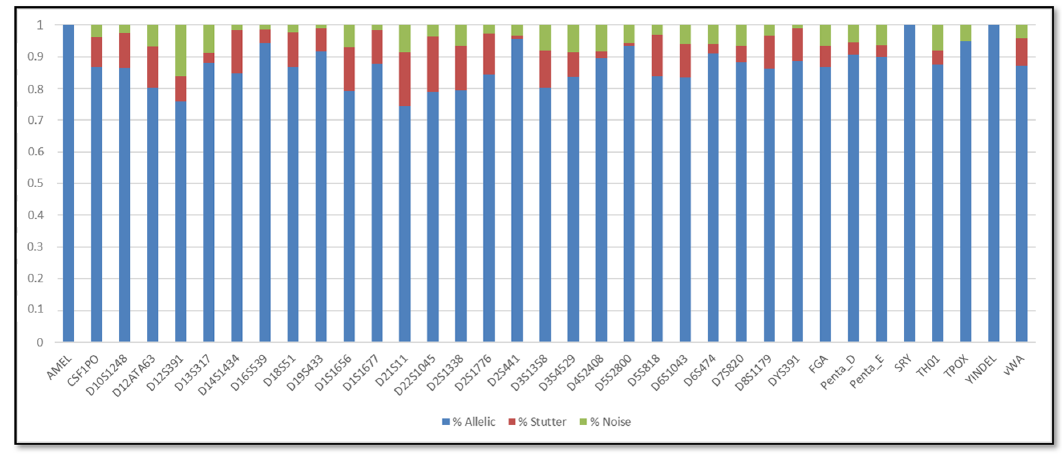
Figure 4. Sequence coverage ratios of the urine mixtures.